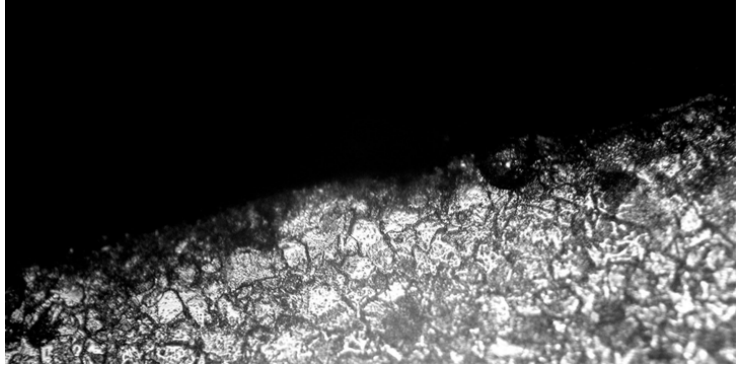
Figure 9: Micrographic analysis. Under site of scale surface. Discontinuous scale due to pronounced penetration. – 200 X.